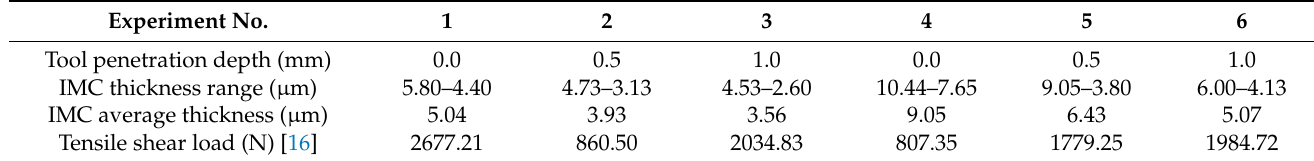
Table 3. IMC thickness range and IMC average thickness and TSL on TPD.